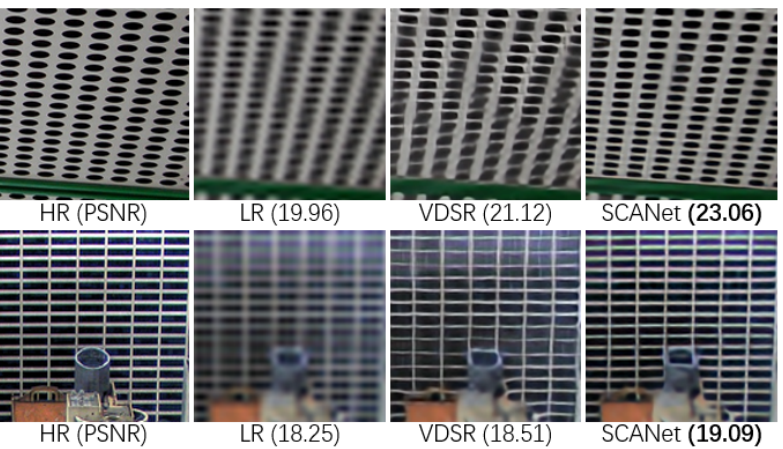
Figure 5. Visual comparisons against the Urban100 benchmark.